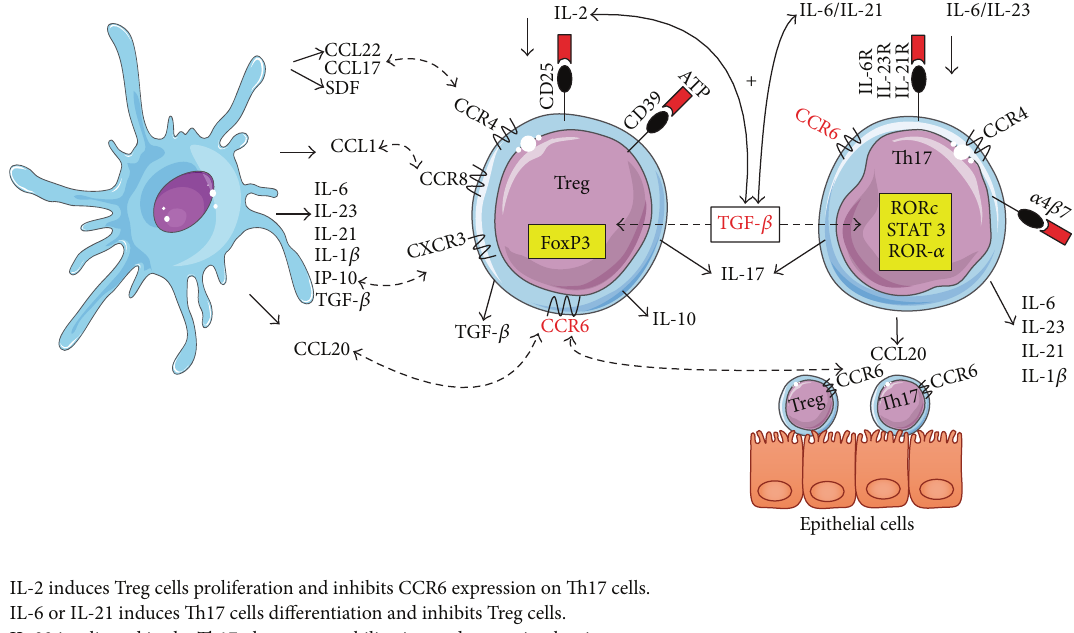
IL-2 induces Treg cells proliferation and inhibits CCR6 expression on Th17 cells. IL-6 or IL-21 induces Th17 cells differentiation and inhibits Treg cells. IL-23 implicated in the Th17 phenotype stabilization and expansion but is not a differentiation factor. IL- 𝛽 and IL-6 amplify Th17 cells differentiation. Figure 1: The interaction network between transcriptional factors, cytokines, chemokines, and their receptors in Th17 and Treg cells. The fine-tuning of Th17/Treg balance is regulated by expression of transcription factors that are activated by cytokines milieu and their receptors. TGF- 𝛽 along with mainly IL-6 induces RORc, ROR- 𝛼 , or STAT3 expression to differentiate Th17 cells while that in combination with IL-2 induces FoxP3 expression to differentiate Treg cells, while homing and immunological cells recruitment of both cell subsets are powerful mechanism mediated by chemokines and their chemokine receptors such as CCR6, CCR4, or CXCR3 which facilitates the recruitment of suppressive Treg and inflammatory effector Th17 cells (e.g., by means of CCR6-CCL20) into the site infection or injured tissue. Of note, other immunological cells, as dendritic cells, influence this balance because they produce cytokines, chemokines, and other molecules that participate in this interaction